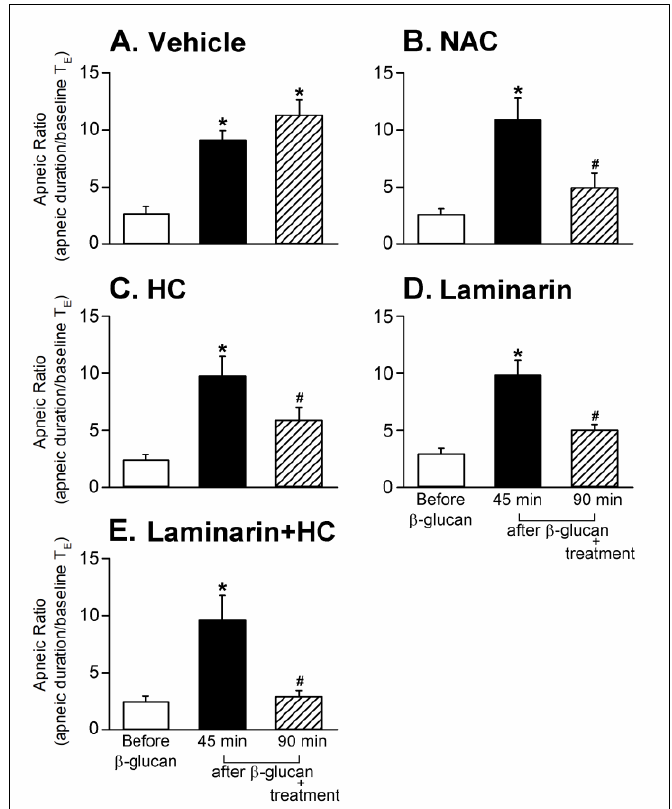
Figure5. E ff ectsoftreatmentwith( A )vehicle, ( B )NAC(0.3g / kg, iv), ( C )HC(8mg / kg, iv), ( D )Laminarin Figure 5. Effects of treatment with ( A ) vehicle, ( B ) NAC (0.3 g/kg, iv), ( C ) HC (8 mg/kg, iv), ( D ) (10 mg / kg, iv) and ( E ) Laminarin + HC on the β -glucan-induced enhancement of pulmonary chemoreflex Laminarin (10 mg/kg, iv) and ( E ) Laminarin + HC on the β-glucan-induced enhancement of responses triggered by capsaicin injection in anesthetized, spontaneously breathing rats. Data are pulmonary chemoreflex responses triggered by capsaicin injection in anesthetized, spontaneously means ± SE ( n = 6). One-way ANOVA followed by Newman-Keuls post hoc test: *, significantly breathing rats. Data are means ± SE ( n = 6). One-way ANOVA followed by Newman-Keuls post hoc di ff erent from before β -glucan ( p < 0.05); # , significant di ff erence when corresponding data between test: *, significantly different from before β-glucan ( p < 0.05); # , significant difference when without and with treatment were compared ( p < 0.05). NAC, N-acetyl-L-cysteine; HC, corresponding data between without and with treatment were compared ( p < 0.05). NAC, N-acetyl- L-cysteine; HC, HC-030031.